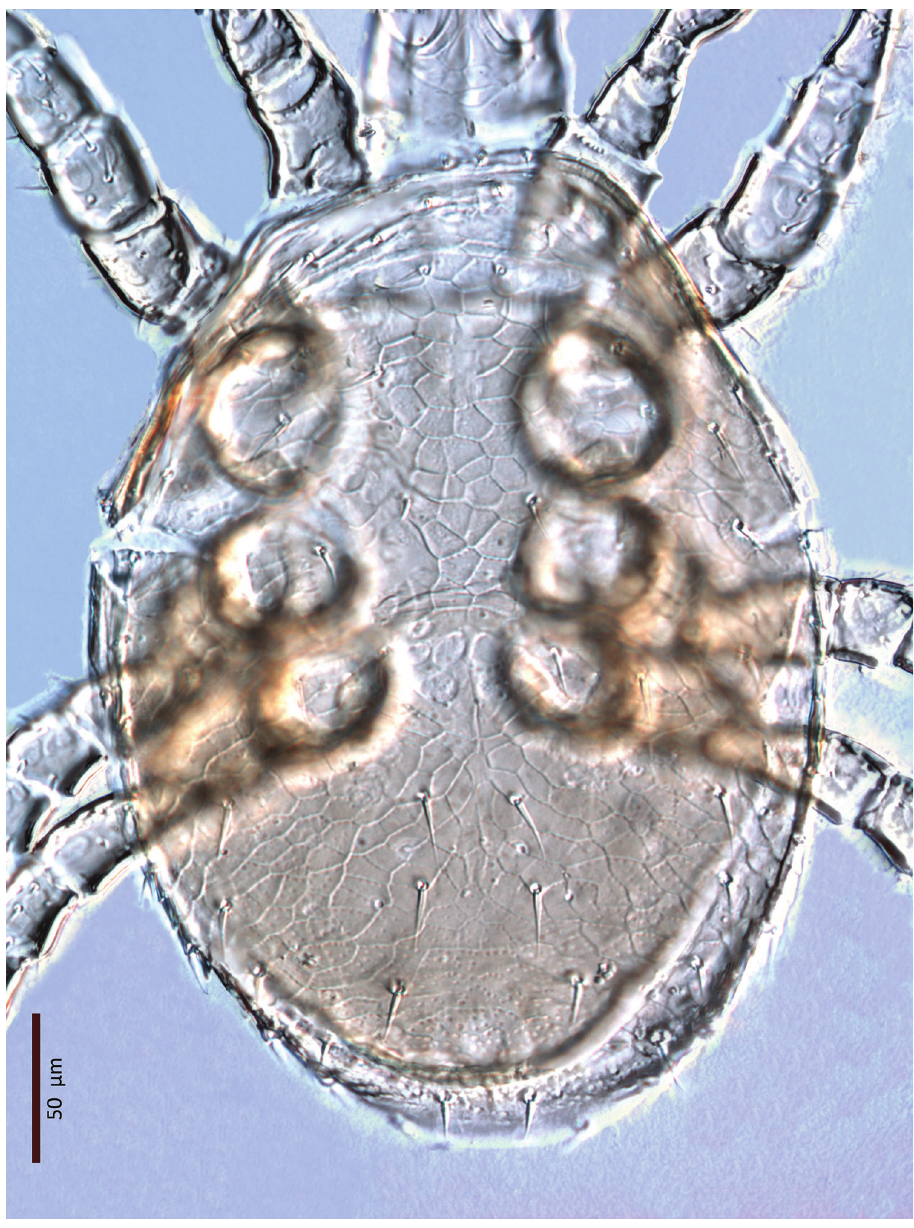
Figure 30. Zygoseius papaver sp. n., male, dorsal idiosoma.